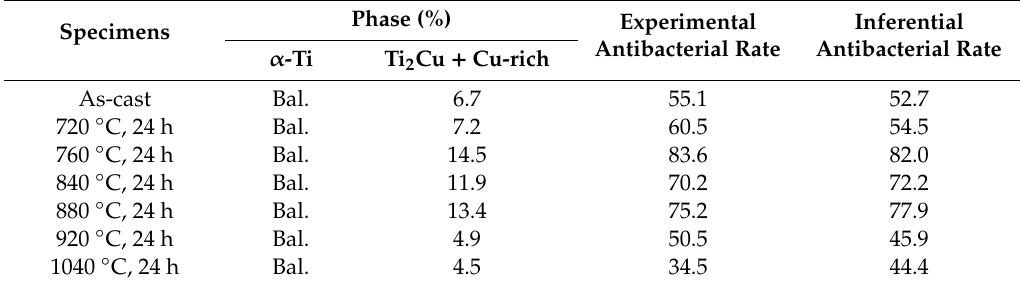
Inferential antibacterial rate ( IAR ) was calculated using the linear regression equation: IAR = BAR